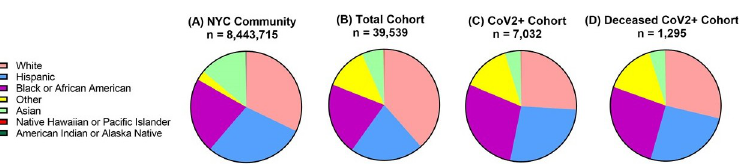
Fig 1. Diversity of Mount Sinai Health System COVID-19 patient population. (A) Ethnic composition of the 2018 New York City catchment population based on US Census Bureau American Community Survey is shown. (B) Mount Sinai Health System cohort is representative of 39,539 patients that entered the health system from February 28 th to June 8 th 2020 with a COVID-19 encounter, whether diagnosed with COVID-19 or were under investigation for infection with the novel coronavirus. (C) Of the cohort, 7,032 patients had positive or presumed positive CoV2 qRT-PCR, and within this confirmed CoV2 positive population, (D) 1,295 patients were deceased.